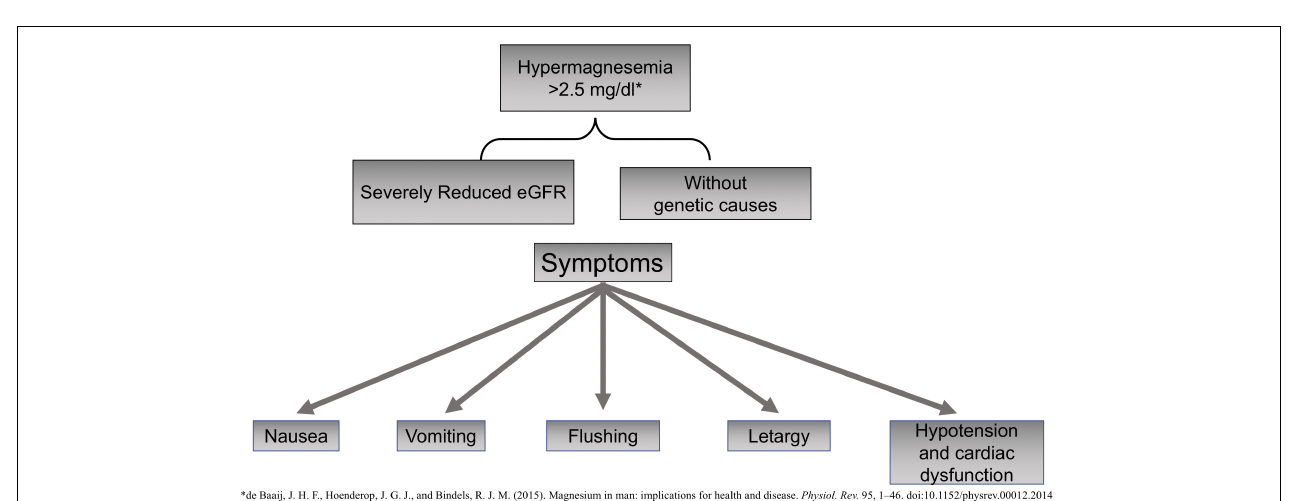
FIGURE 1 | Potential causes of Hypomagnesemia.